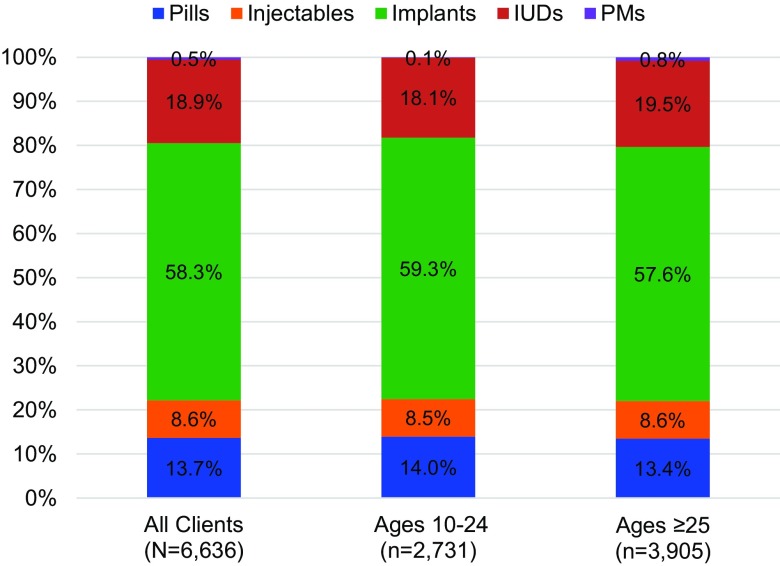
Method Mix Among Postabortion ContraceptorsAbbreviations: IUDs, intrauterine devices; PMs, permanent methods.